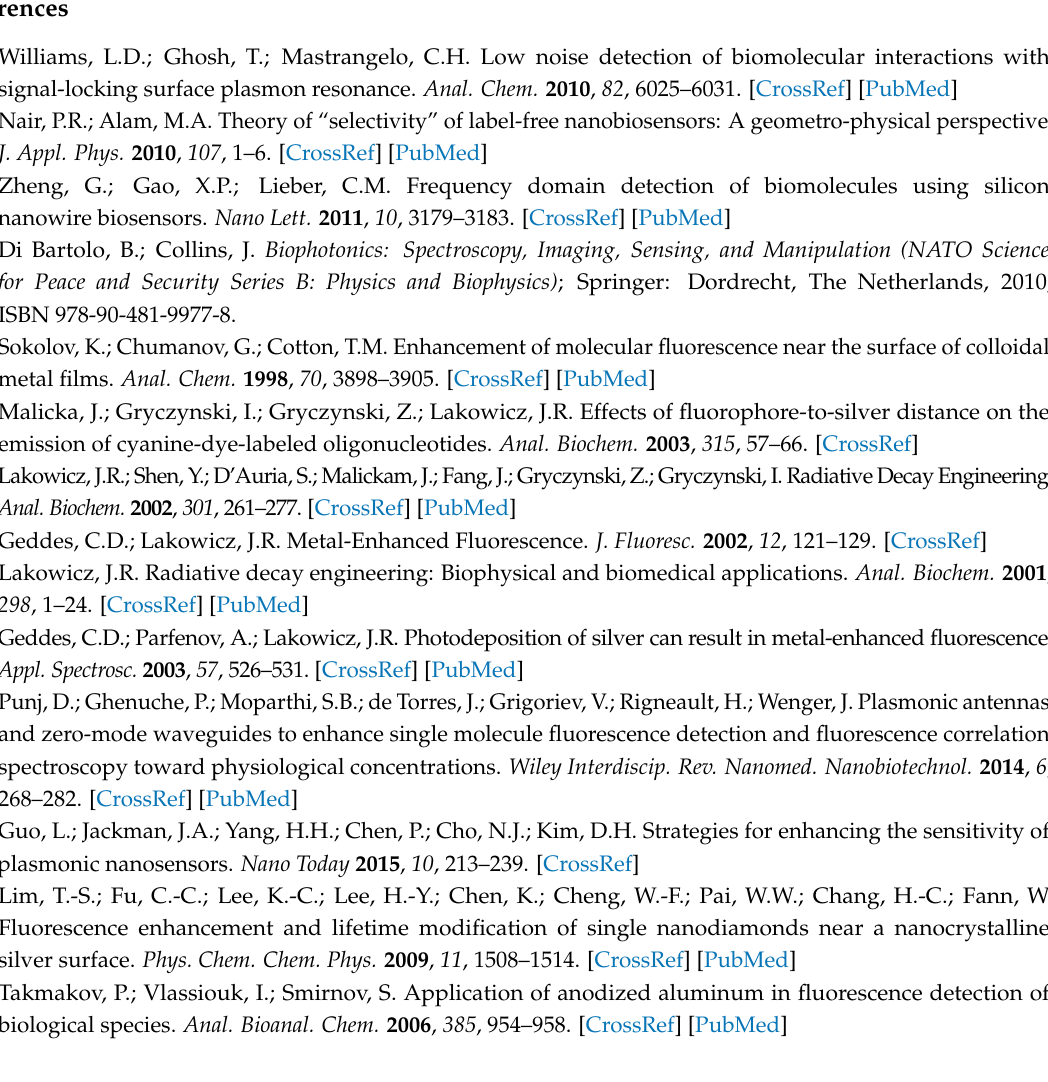
Figure S1: (a) and (b) represent reflectance curves as a function of incident angle for single layer of Au and Ag of various thicknesses, respectively. (c) and (d) represent enhancement of electric field intensity versus distance from the metallic surface in a liquid region at excitation wavelength ( λ ex = 470